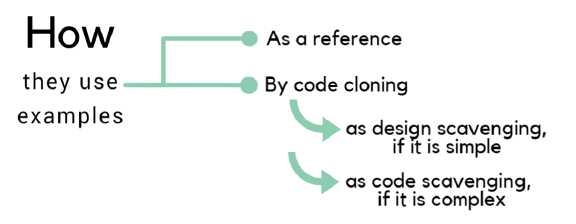
Fig. 4. How novice programmer use